Question: According to the figure, is the described quantity increasing or decreasing?
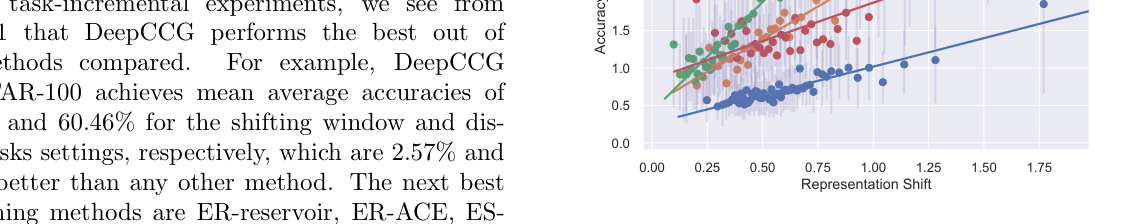
Answer: increasing